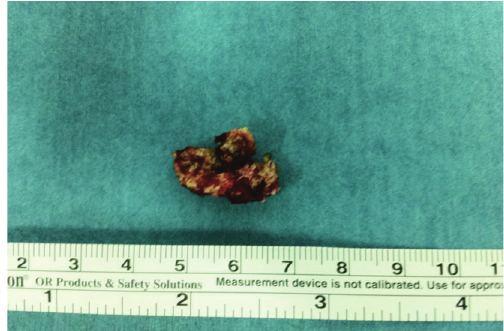
Figure 2: Tophi gouty of 2,5cm after